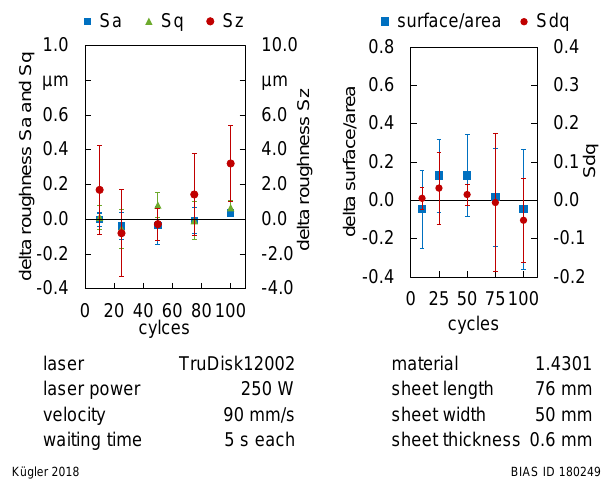
Figure 11. Influences on standard roughness value measurements ( left ), and the hybrid roughness value Sdq and topography factor surface/area ( right ) for varying laser processing cycles with a 5 s waiting time after each cycle.